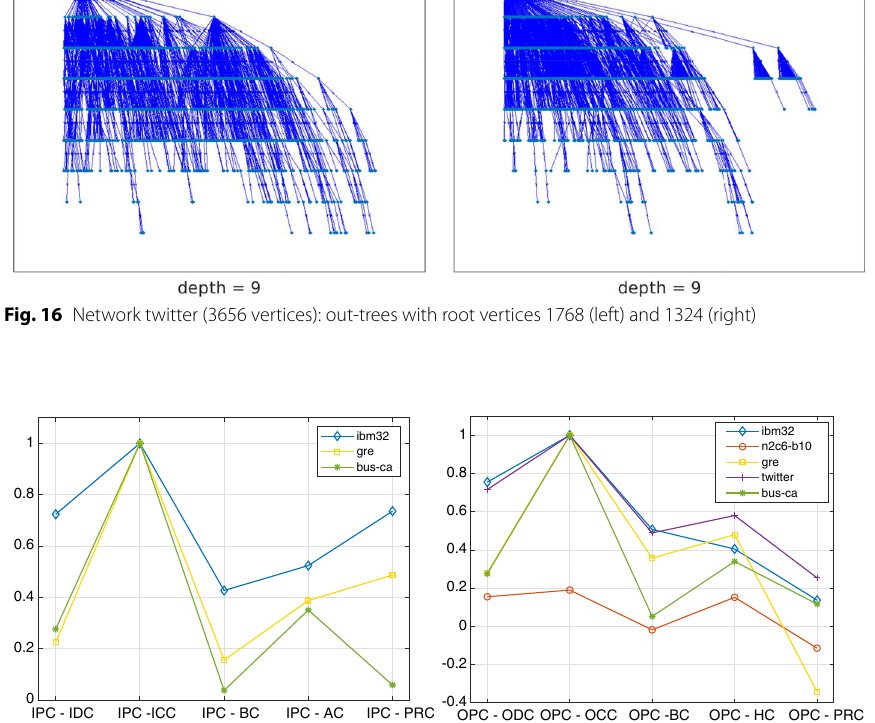
Fig. 17 Kendall rank correlation coefficient between the in/out position centrality (IPC/OPC) and degree (IDC/ODC), closeness (ICC/OCC), betwenness (BC), hub/authority (HC/AC), and PageRank (PRC) centralities. The graph on the left concerns the incoming connections, the one on the right the outgoing ones. The computation has been performed for all the networks considered in the